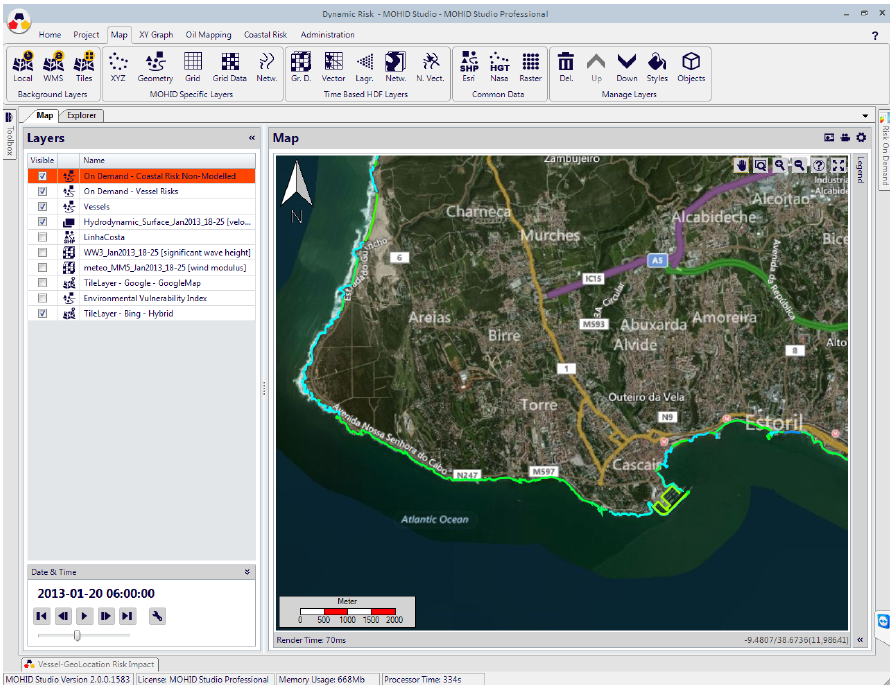
Figure 4. Close-up image of the GUI for the Lisbon area – simultaneous visualization of coastal sensitivity index and Bing Hybrid map